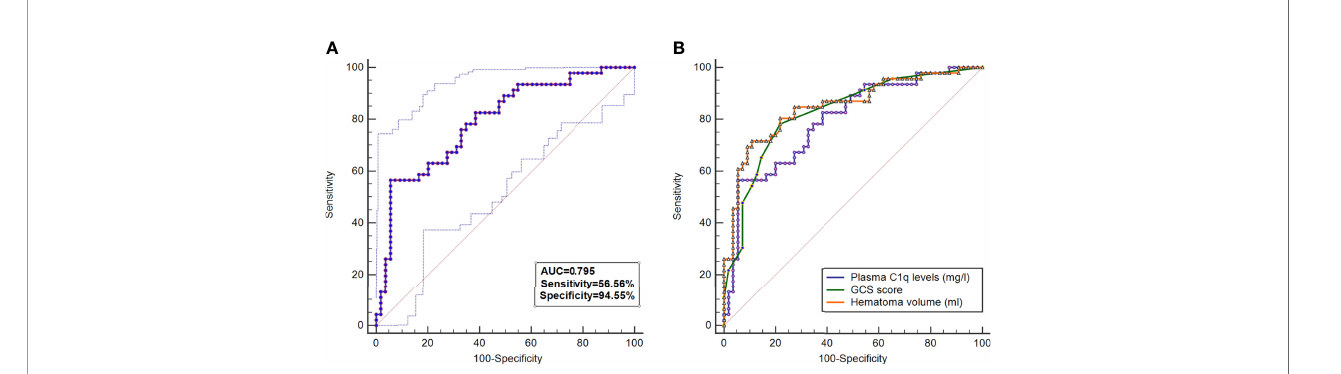
FIGURE 5 | Predictive value of plasma C1q levels for poor outcome at 3 months after intracerebral hemorrhage. (A) Under the receiver operating characteristic curve, plasma C1q levels signi fi cantly discriminated development of poor prognosis (area under curve 0.795; 95% con fi dence interval, 0.703 – 0.869; P < 0.001). Using maximum Youden method, plasma C1q levels > 270.11 mg/l distinguished patients at risk of 3-month poor prognosis with 56.52% sensitivity and 94.55% speci fi city. AUC denotes area under curve. (B) Comparison of discriminatory capability with respect to plasma complement component 1q levels, Glasgow Coma Scale score and hematoma volume for 3-month poor prognosis following acute intracerebral hemorrhage under receiver operating characteristic curve. Poor prognosis was de fi ned as Glasgow Outcome Scale score 1-3. Prognostic predictive ability of plasma Complement component 1q levels (area under curve, 0.795; 95% con fi dence interval, 0.703-0.869) was similar to those of Glasgow Coma Scale score (area under curve, 0.827; 95% con fi dence interval, 0.739-0.895; P=0.425) and hematoma volume (area under curve, 0.850; 95% con fi dence interval, 0.765-0.913; P=0.205). GCS indicates Glasgow Coma Scale.